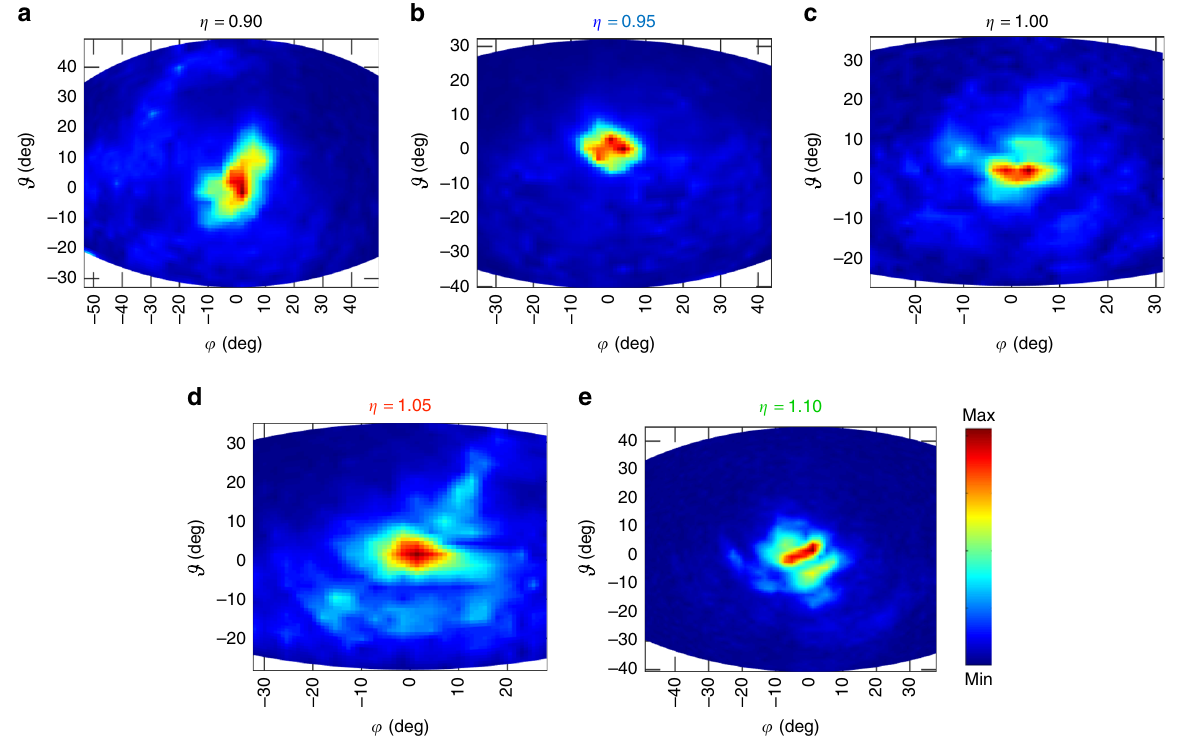
Fig. 4 Far- fi eld intensity patterns. Far- fi eld emission patterns measured at 20 K while driving the devices in pulsed mode with 2% duty cycle, for wire lasers having different extraction parameters: a η = 0.90, b η = 0.95, c η = 1.00, d η = 1.05, e η = 1.10. All the measurements were performed scanning a pyroelectric detector at a distance of ~8 cm from the device lateral surface. The origin (0,0) of the plots is coincident with the origin of the x – y – z reference system of Fig. 2a. The scanned area is 12×12 as a function of the extraction wavevector (Fig. 4a – e). For the case of η = 0.95, the beam is single-lobed and localized within a beam pro fi le of Δ φ ≈ Δ ϑ ≈ 10° (Fig. 4b).